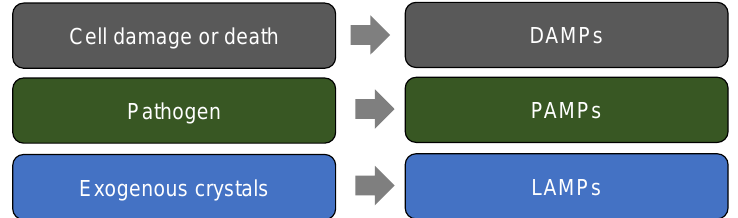
Figure 2. DAMPs vs. PAMPs vs. LAMPs.